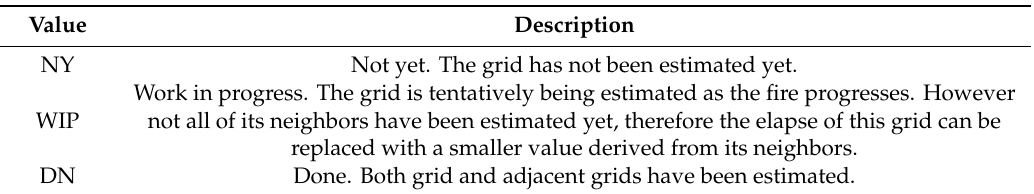
Table 6. Assess status.